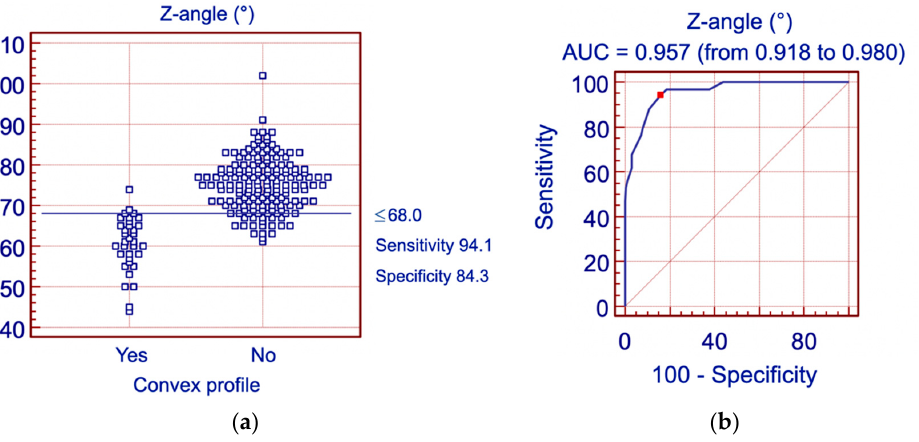
Figure 8. Analysis of the Z-angle with reference to the profile convexity: ( a ) Histogram; ( b ) ROC curve for the Z-angle. AUC—area under curve.